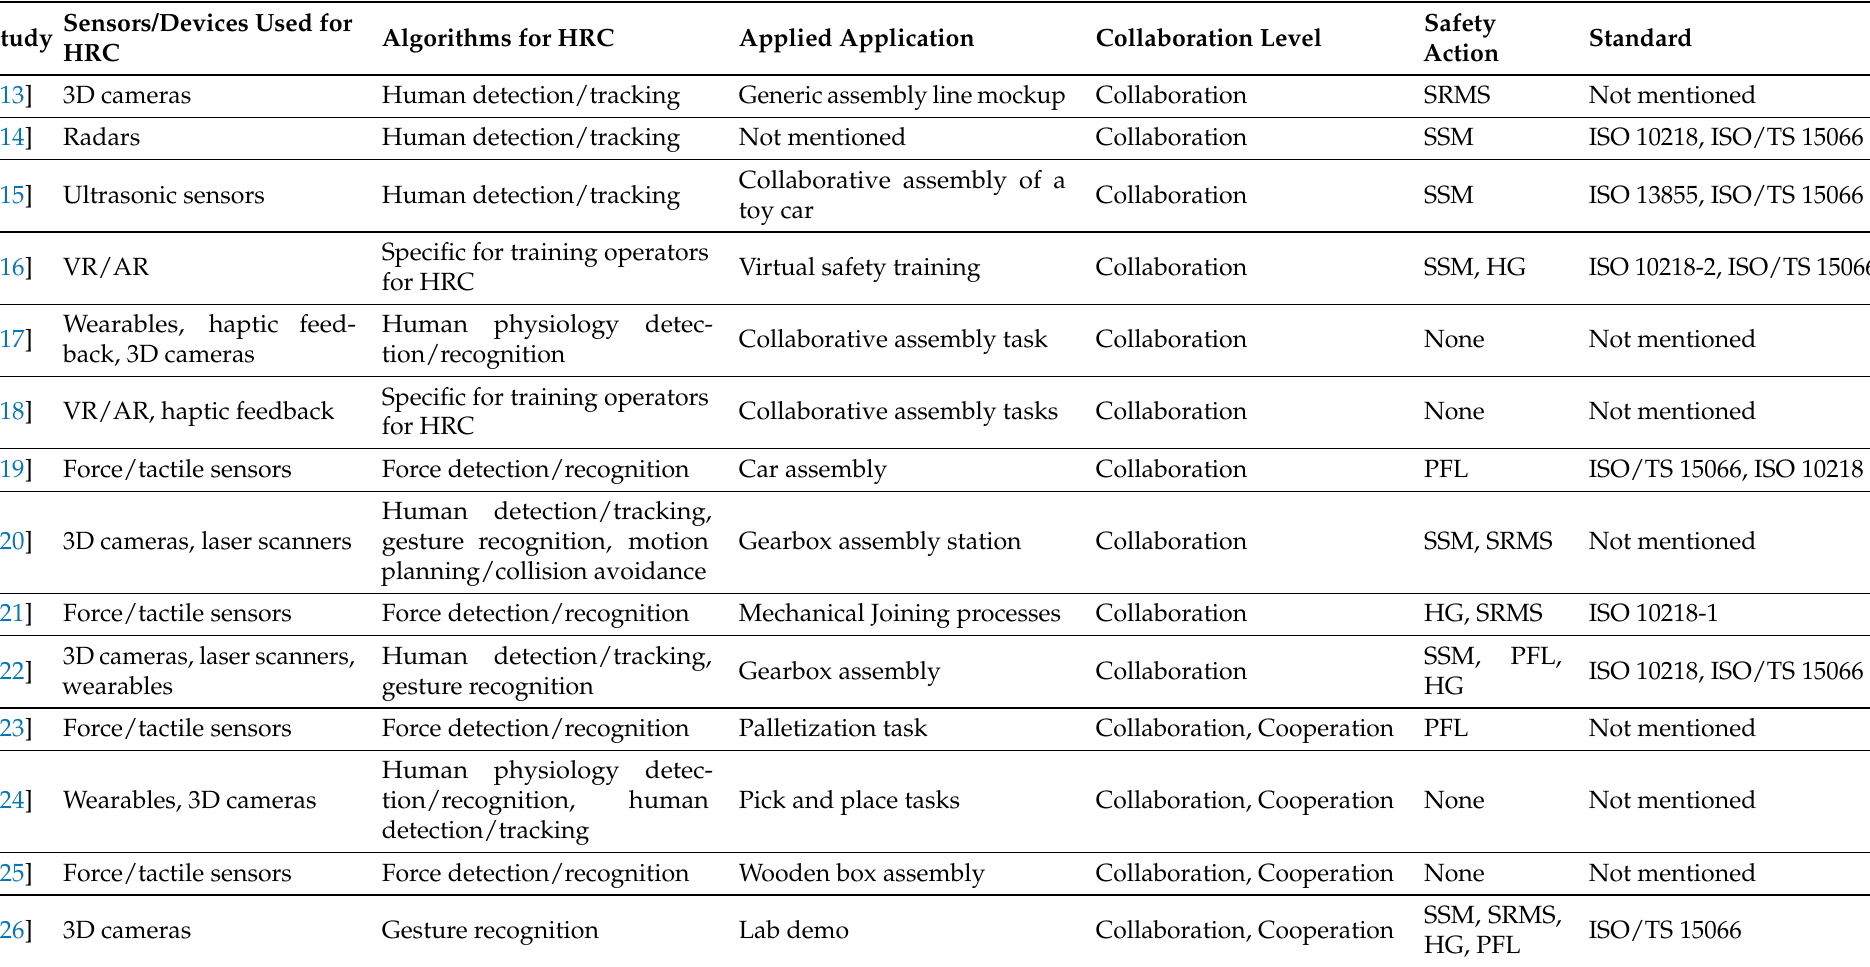
Table 2. Extracted